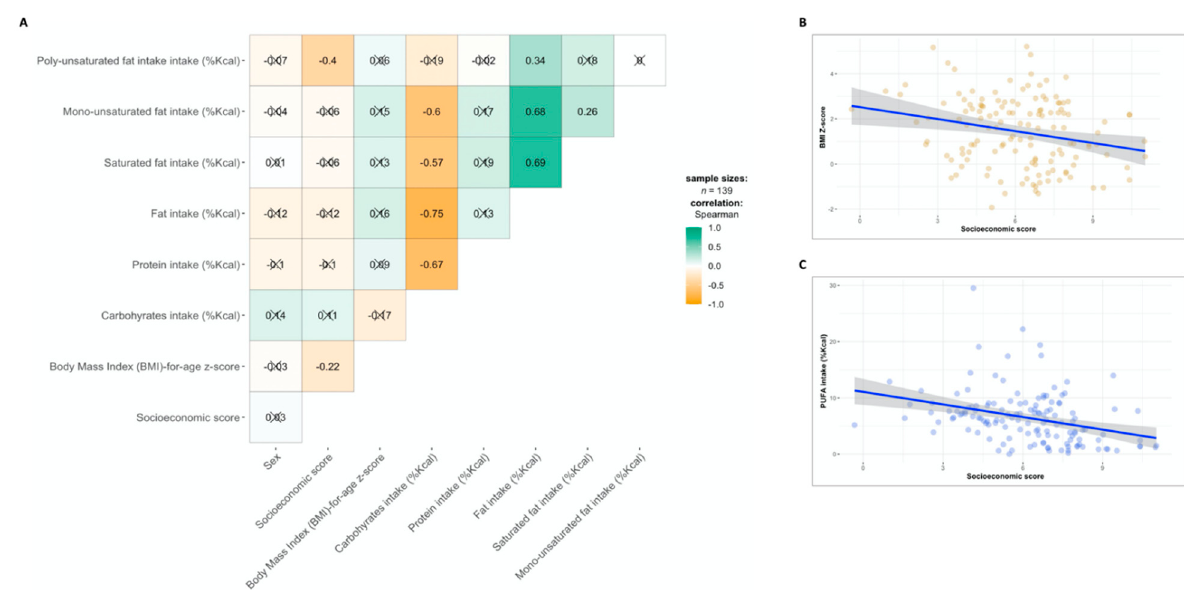
Figure 1. Socio-demographic characteristics and dietary intake ( A ) Correlation matrix of Spearman’s correlation coefficients across the study variables. Positive correlations are colored in green and inverse correlations are colored in orange. ( B ) A scatter plot of the correlation between BMIZ score and SES score. ( C ) A scatter plot of the correlation between intake of PUFAs (%Kcal) and SES score. X in the figure represents non-significant correlation ( p > 0.05 adjusted for FDR). Table 1. Demographic characteristics and dietary intake of the study The BMIZ score was negatively correlated with SES scores (Spearman’s r = − 0.22, p =